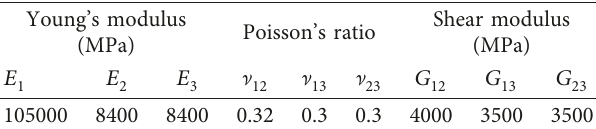
Figure 7: Definition of the fiber direction angle and the line crack angle. Table 1: Material parameters of composite lamina.